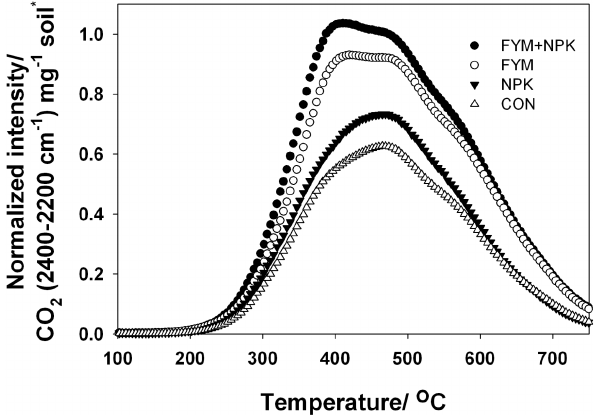
fertilizer), Control (no fertilizer inputs).